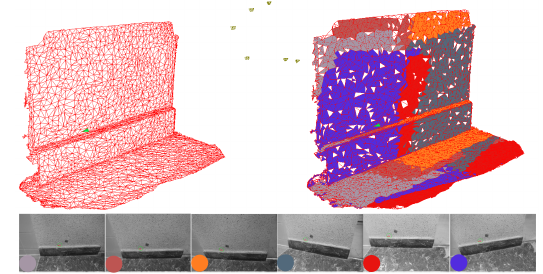
Figure 4. Partrition of the scene between master images. Top-left: 3D mesh, top-right: each color represents one master image, bottom: master images with their color represented in scene.